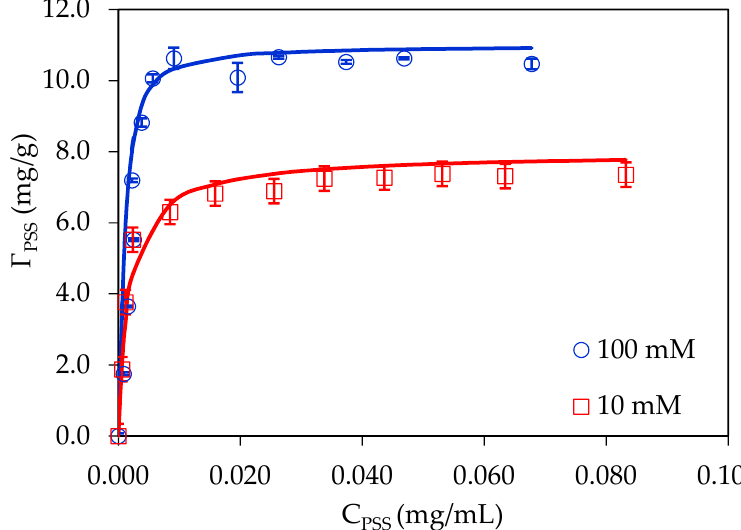
Table 1. Fit parameters for the adsorption isotherms onto Al 2 O 3 at different NaCl concentration (pH 4). The maximum adsorbed amount Γ ∞ ,(cid:2900)(cid:2903)(cid:2903) , the equilibrium constants k 1,PSS , k 2,PSS for first layer and multilayer, respectively, n the number of clusters of PSS molecules.